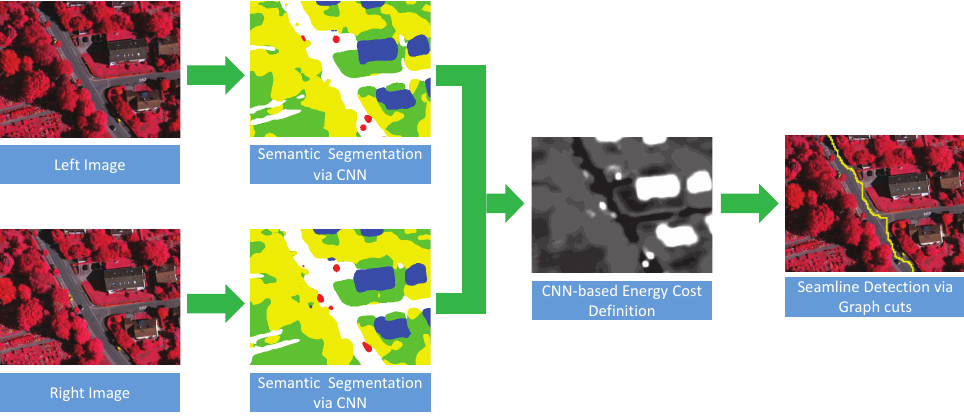
Figure 1. The overview of our proposed optimal seamline detection